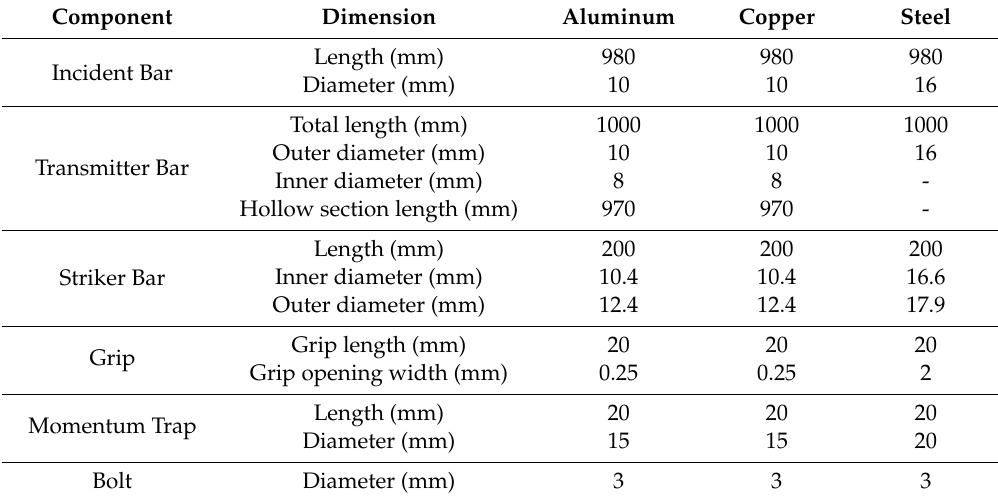
Figure 5. Stress–strain curve for the steel casing on different values of strain rate in ms -1 .